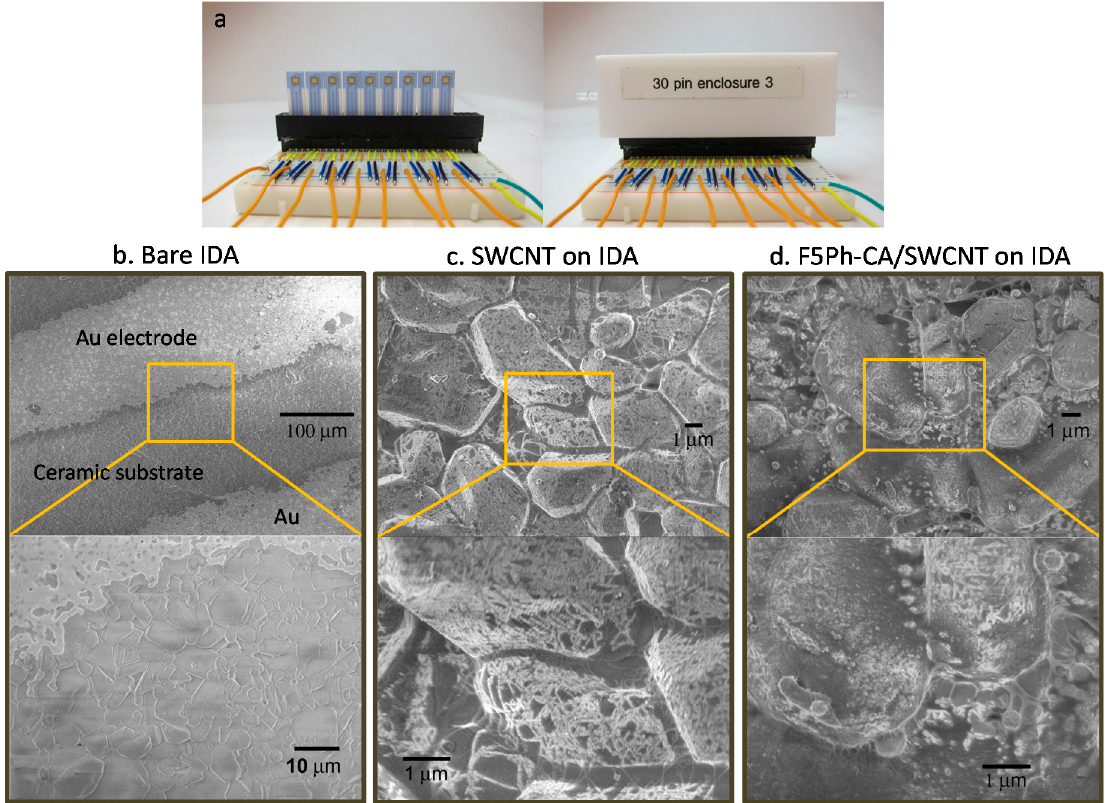
Figure 3. ( a ) Photographs of the array device containing 9 sensors deposited on interdigitated microelectrode array (IDA). SEM images of ( b ) bare IDA, ( c ) SWCNTs on IDA, and ( d ) F5Ph-CA/SWCNT on IDA.